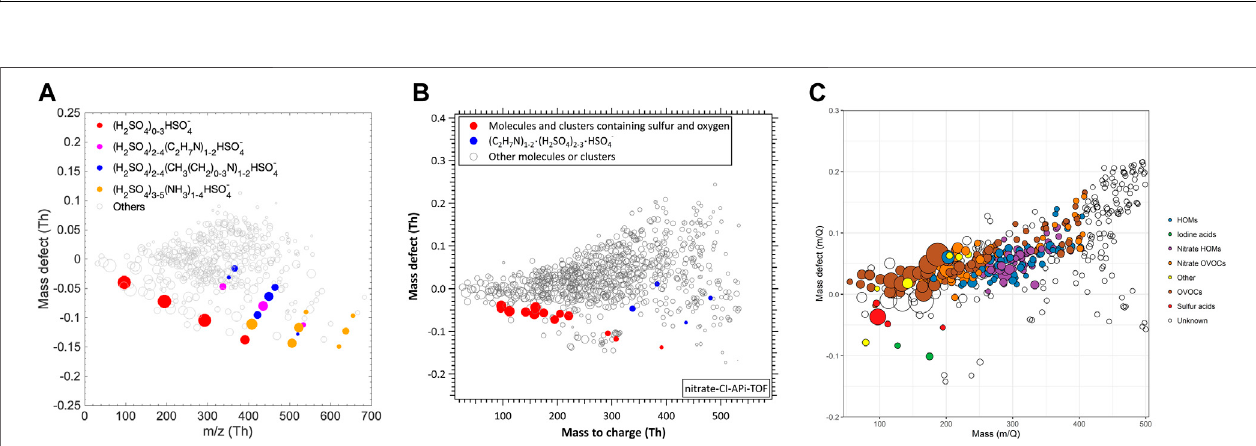
FIGURE 2 | CI-Api-TOF mass spectra taken from the CLOUD chamber from a multicomponent nucleation system containing sulfuric acid, ammonia, HOMs, and NO x (A) and in a Finnish boreal forest during an NPF event (B) . Adapted from Lehtipalo et al. (Lehtipalo et al.,